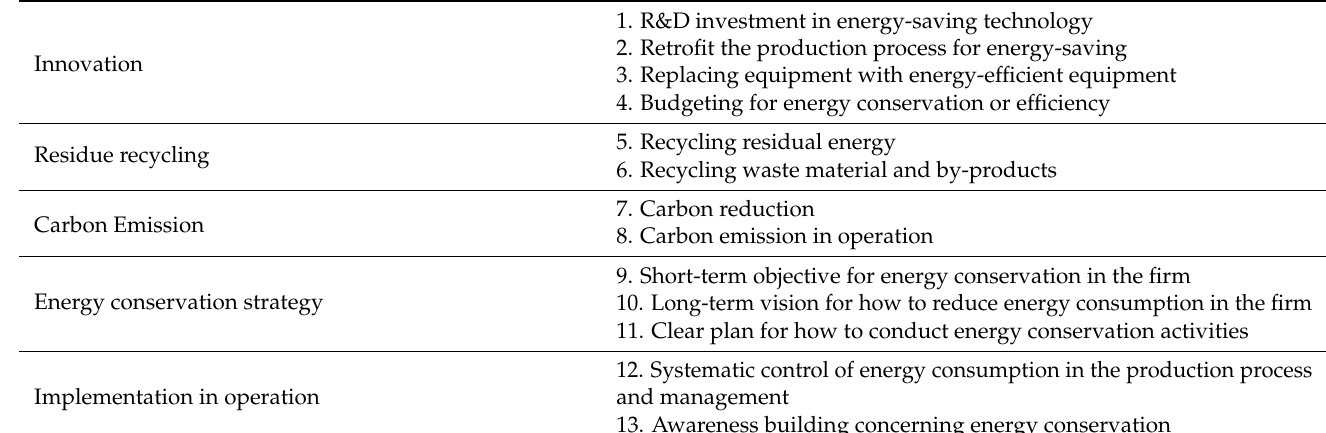
Table 1. Energy conservation index.